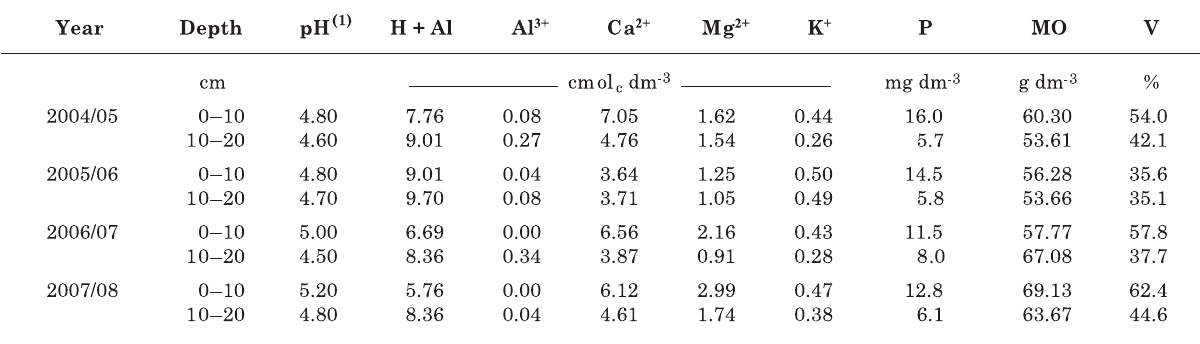
Table 1. Soil chemical attributes of the experimental areas during the four growing